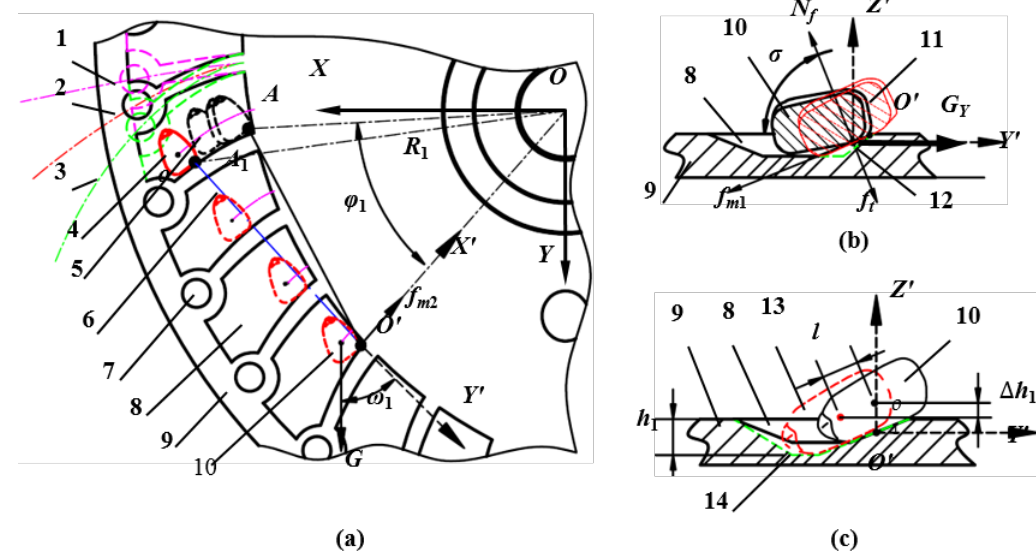
Figure 5. Key parameter design of the pneumatic maize seed meter. ( a ) Curvature coefficient of seed guide groove curve; ( b ) Inclined angle of the seed guide groove; ( c ) Depth of the seed guide groove. Note: 1, Seed guide groove curve when γ = 0.9; 2, seed guide groove curve when γ = 0.5; 3, seed guide groove curve when γ = 0.1; 4, target seed after moving; 5, relative trajectory of seed; 6, absolute trajectory of seed; 7, shaped hole; 8, seed guided groove; 9, seed-metering plate; 10, target seed before moving; 11, seed in seed guide groove with small inclined angle; 12, inclined surface of seed guide groove; 13, seed in deeper seed guide groove; 14, deeper seed guide groove; XOY is absolute coordinate system while X ′ O ′ Y ′ is the relative coordinate system.